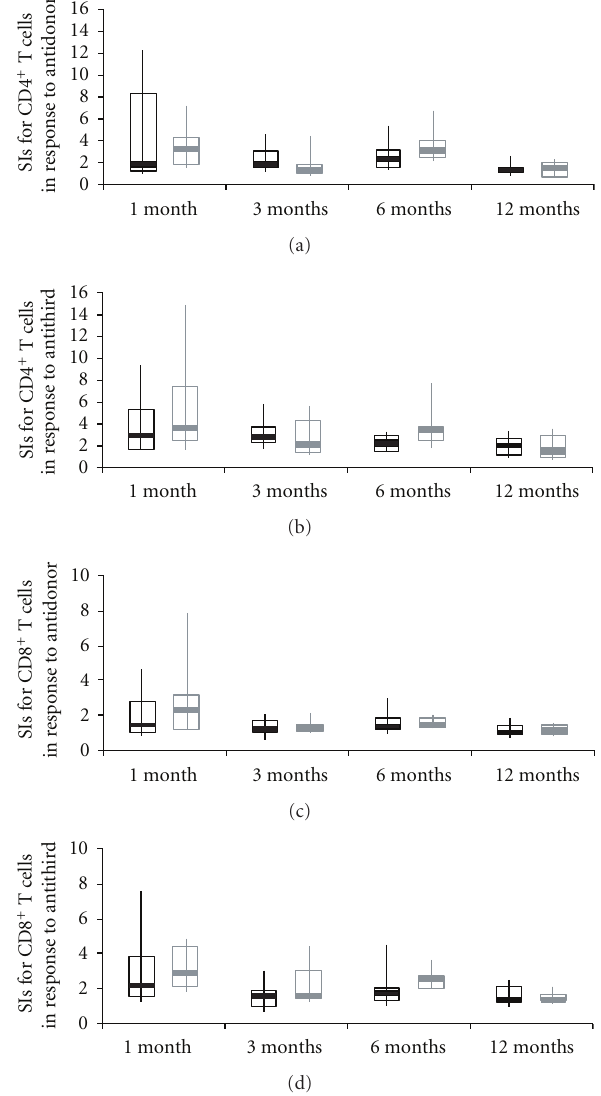
Figure 3: Kinetics of stimulation index in the RI group and non- RI group during the first year after transplantation. Stimulation index (SI) of each of the CD4 + T-cell (a, b) and CD8 + T-cell (c, d) subsets in the antidonor (a, c) and anti-third-party (b, d) MLR in patients in non-RI group (black line) and RI group (gray line). CD4 + and CD8 + T-cell proliferation and their SIs were quantified as follows. The number of division precursors was extrapolated from the number of daughter cells of each division, and the number of mitotic events in each of the CD4 + and CD8 + T-cell subsets was calculated. Using these values, the mitotic index was calculated by dividing the total number of mitotic events by the total number of precursors. The SIs of allogeneic combinations were calculated by dividing the mitotic index of a particular allogeneic combination by that of the self-control. The box plot represents the 25th to 75th percentile, the dark line is the median, and the extended bars represent the 10th to the 90th